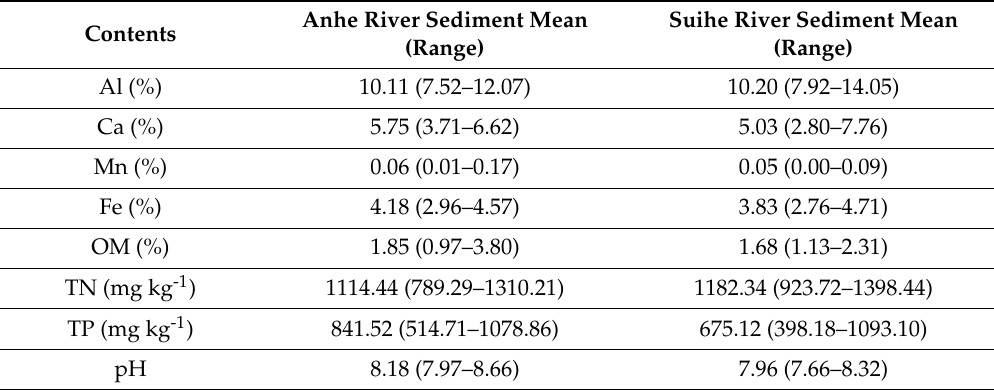
Table 1. Physical and chemical characteristics of sediment properties of Anhe River and Suihe